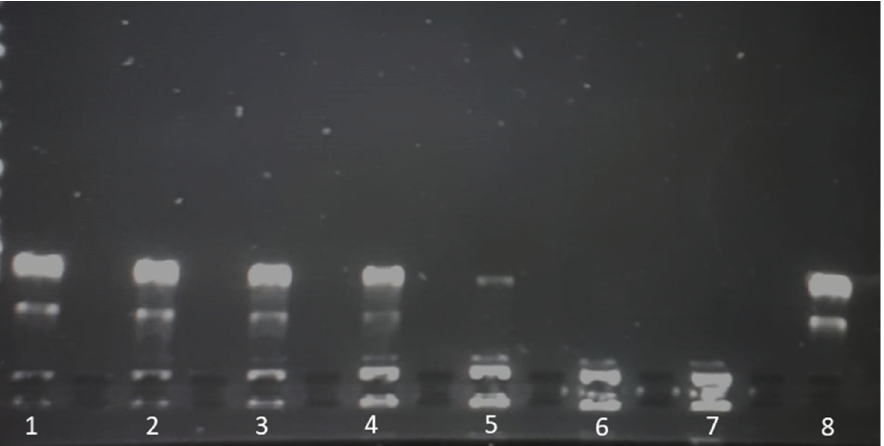
Figure 5. 1% Agarose gel electrophoresis of pCMVkan-S in PBS: DOTAP4/pCMVkan-S N/P ratio 0.25:1 (1), 1:1 (2), 5:1 (3), 10:1 (4), 25:1 (5), 50:1 (6), 100:1 (7), and naked pCMVkan-S (8). Migration was performed in TBE buffer at 80 V for 30 min.